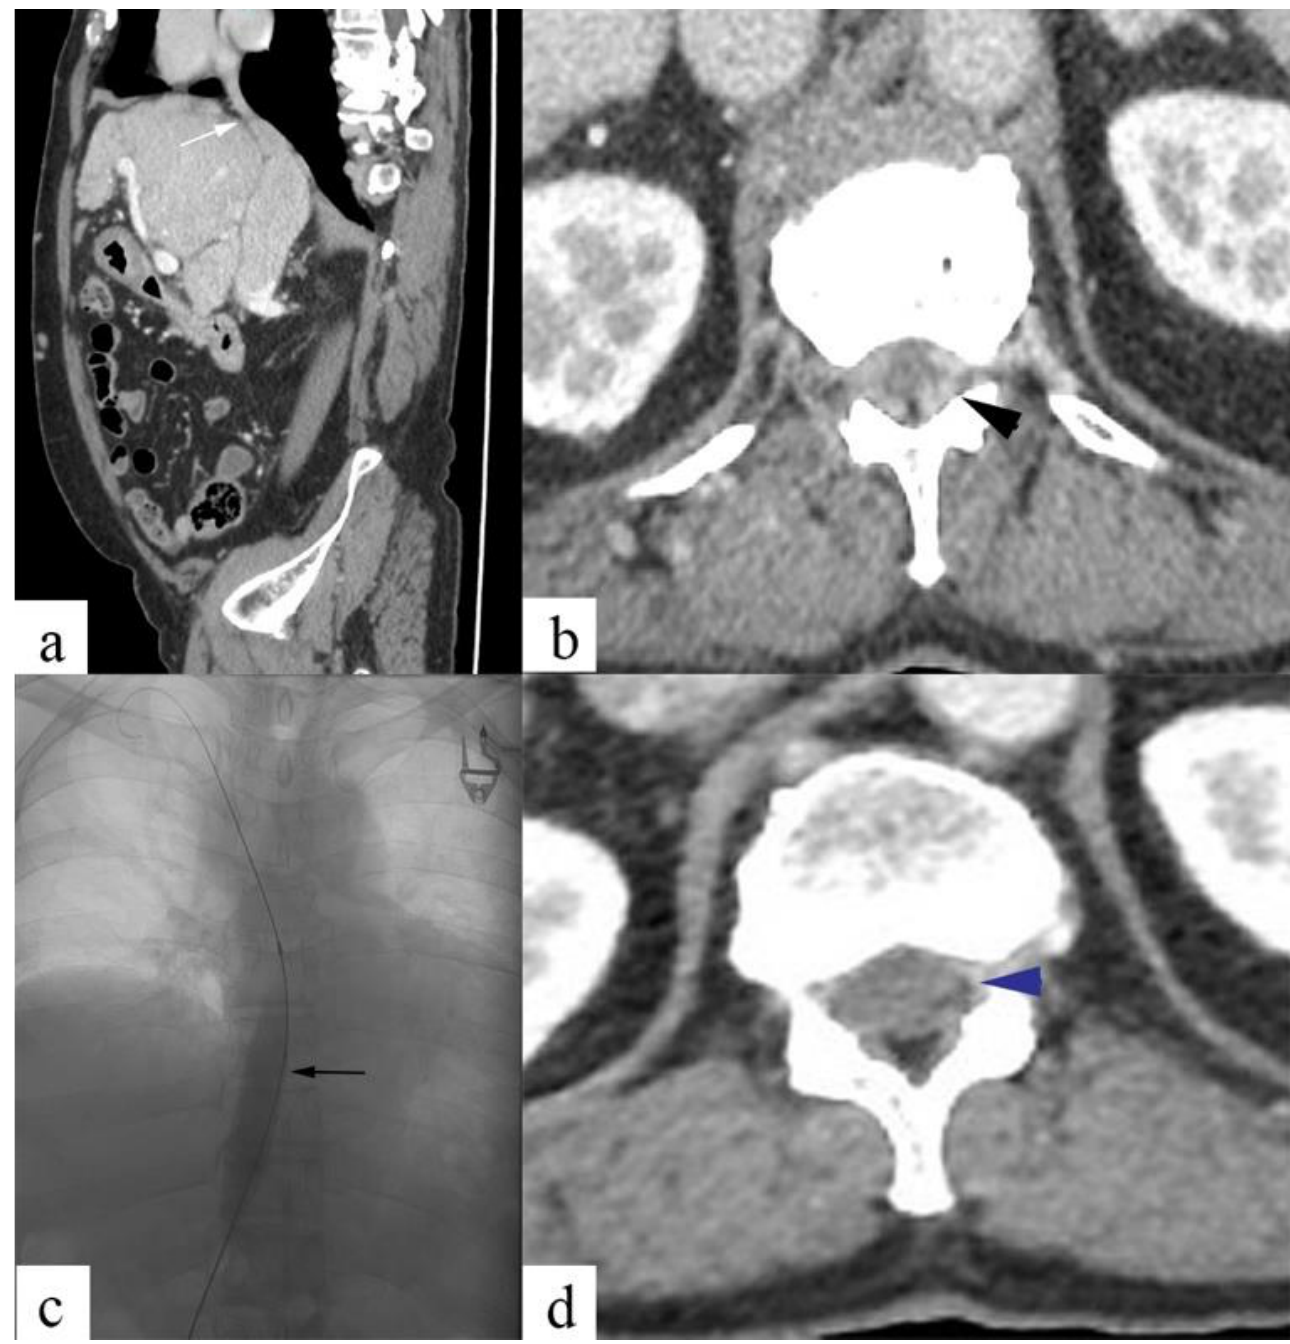
Figure 3. Membranous IVC obstruction in a 29-year-old male patient with Budd – Chiari syndrome and back pain. Contrast-enhanced CT images show membranous IVC obstruction at the suprahepatic IVC (3 a ; white arrow) and epidural venous plexus enlargement (3 b ; black arrowhead). Balloon angioplasty was performed for IVC obstruction (3 c ; black arrow), following which the resolution of EVEs (3 d ; blue arrowhead) was noted, along with back pain relief.